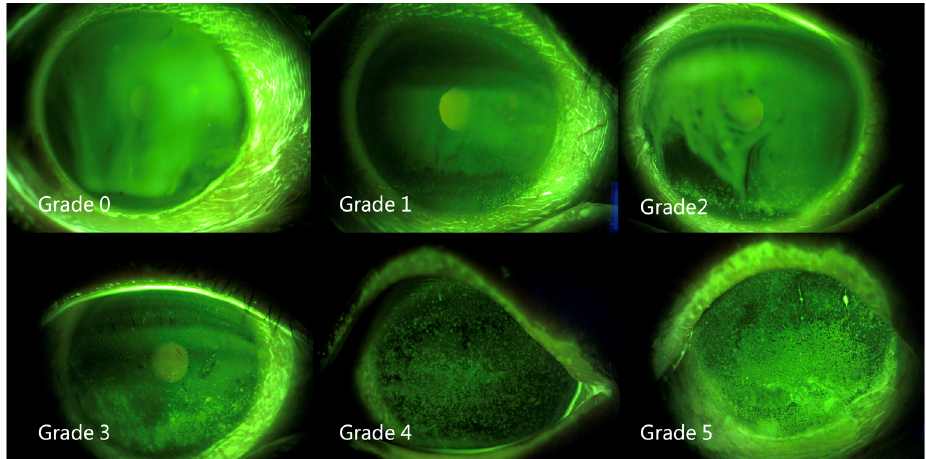
Figure 3. Representative external eye photographs of fluorescein stain.